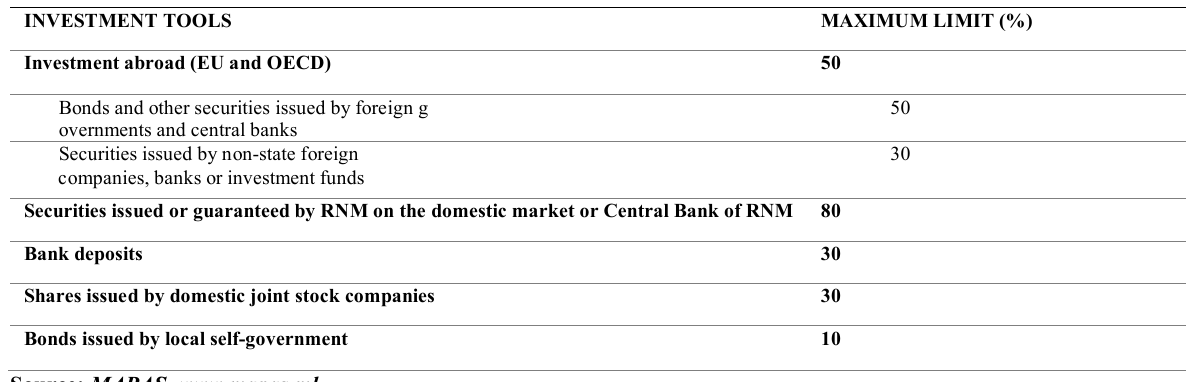
Table 4: Investment tools and maximum investment limits